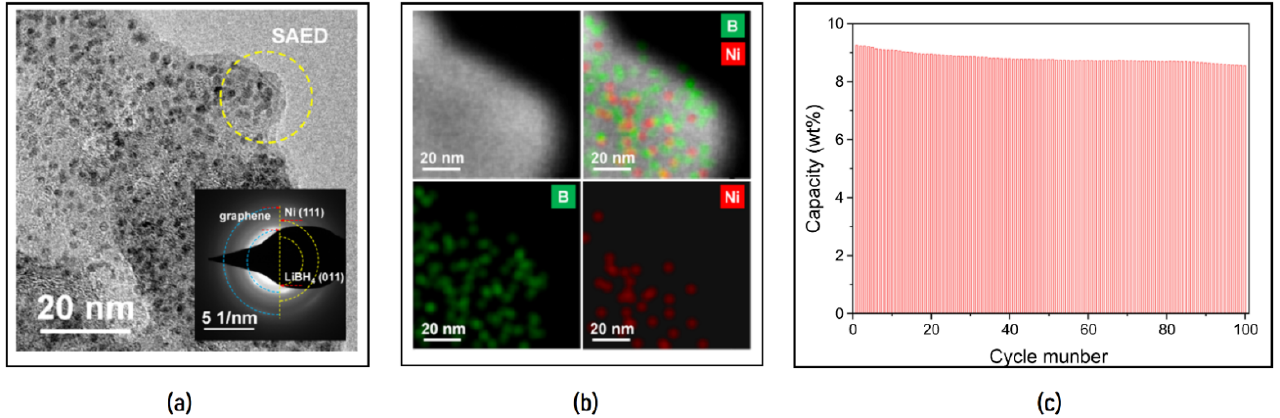
Figure 8. ( a ) Transmission electron microscopy (TEM) image; ( b ) energy-dispersive X-ray spectroscopy (EDX) mapping and ( c ) hydrogen cycling stability of nano-LiBH 4 supported on graphene decorated with Ni. Reprinted with permission from [99]. Copyright (2021), Elsevier.